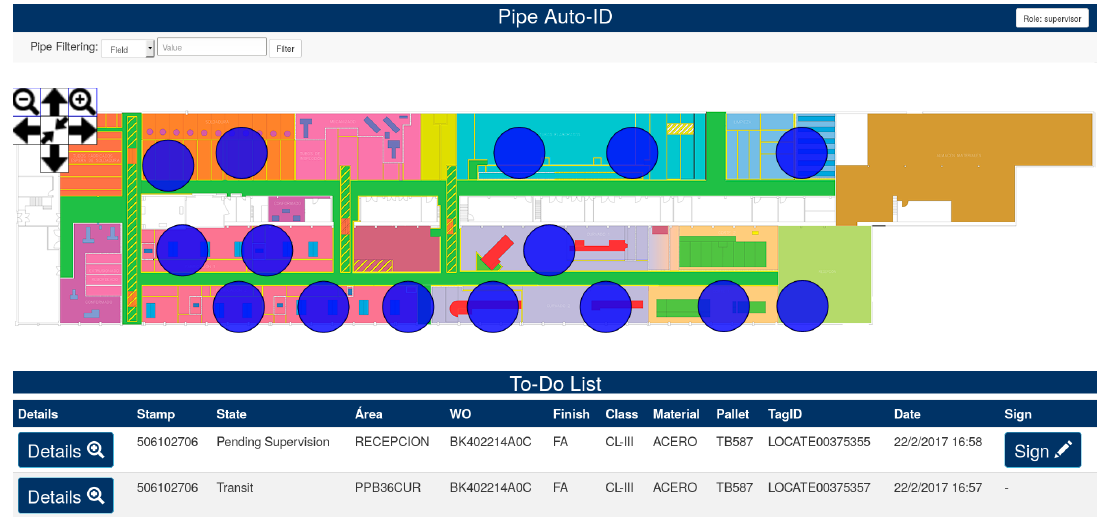
Figure 11. Display module interface.